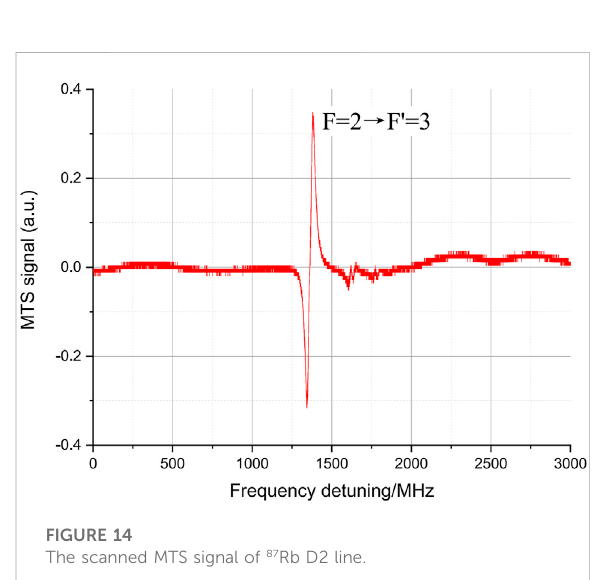
FIGURE 15 The frequency stability of IF-ECDL with